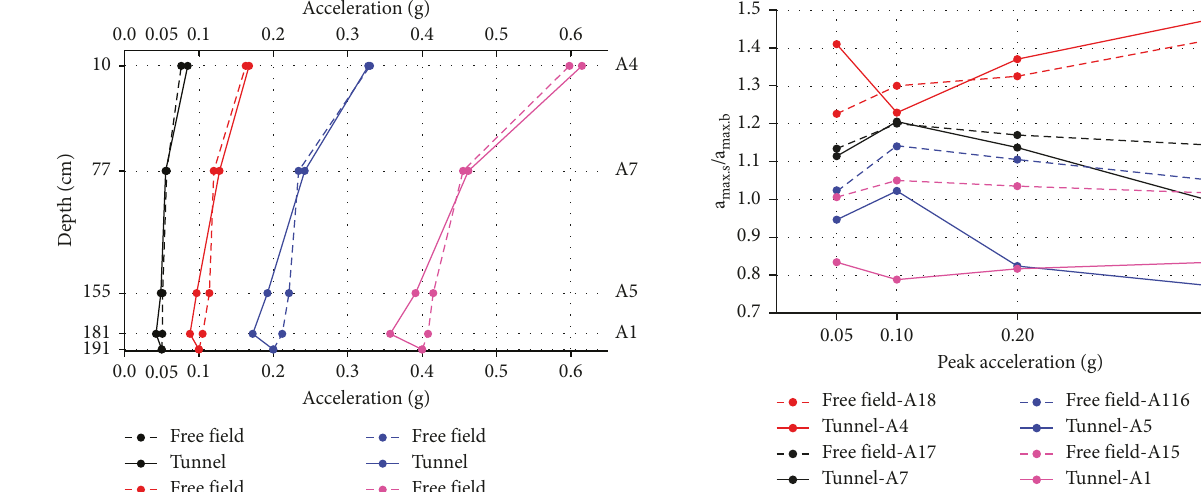
Figure 10: Amplification factor of the